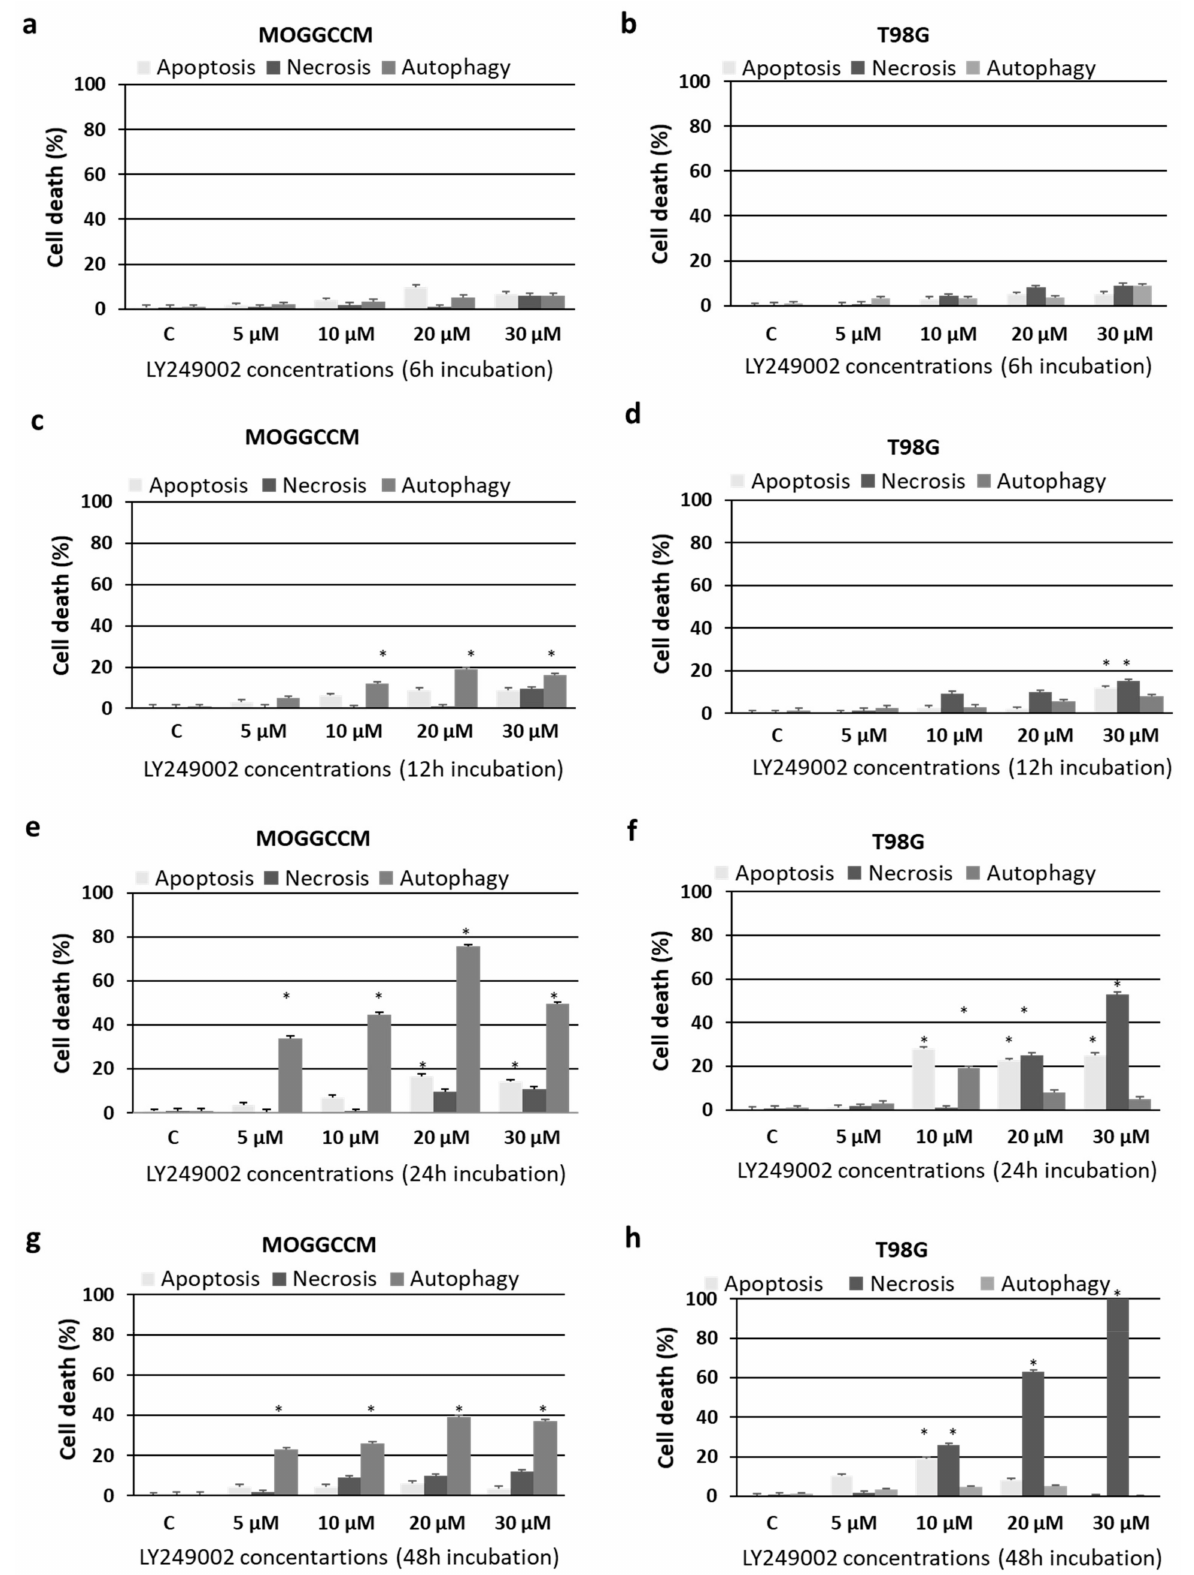
Figure 1. The effect of different concentrations of LY294002 on the levels of apoptosis, autophagy, and necrosis identified microscopically after staining with Hoechst 33342, acridine orange, and propidium iodide, respectively, in anaplastic astrocytoma (MOGGCCM; ( a , c , e , g )) and glioblastoma multiforme cells (T98G; ( b , d , f , h )) incubated with the compound for 6 ( a , b ), 12 ( c , d ), 24 ( e , f ), or 48 ( g , h ) h. C—control, * p < 0.01 compared to